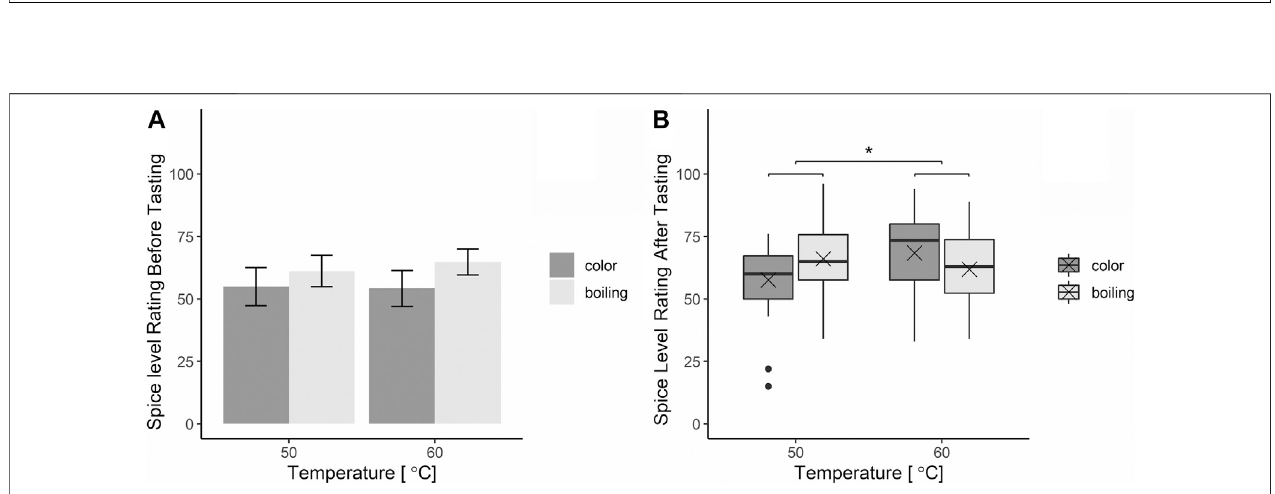
FIGURE3|(A) Saltiness ratings beforetasting and (B) after tasting. The “ * ” , “ ** ” , “ *** ” marksrepresent thesigni fi cantdifference when p < 0.05, p < 0.01, p < 0.001, respectively. The error bars in the bar plots represent the standard error. For the box plots, the bold lines indicate the median, the boxes signify the range from the fi rst quartile to the third quartile, the whiskers indicate the minimum and maximum values, the cross marks represent the mean average, and the points indicate the outliers.